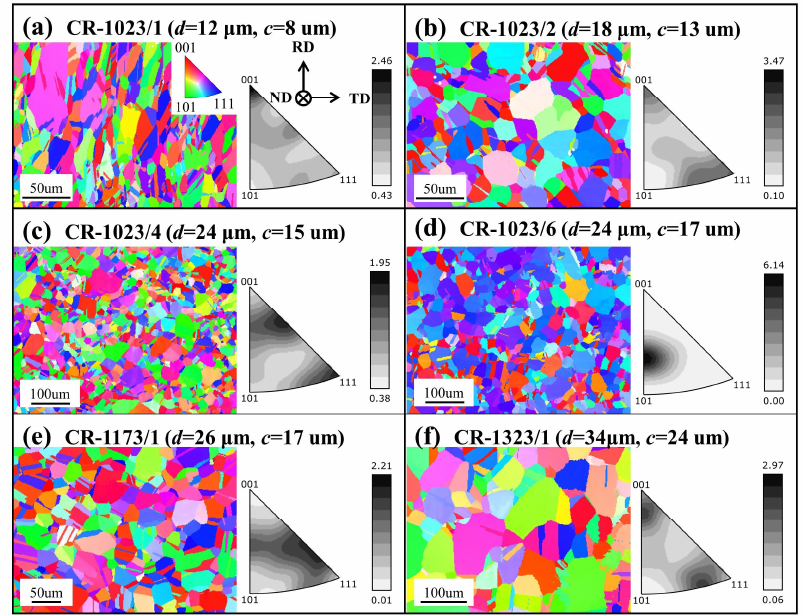
Figure 5. Representative microstructures and corresponding inverse pole figures showing the tex- ture parallel to the rod axis of recrystallized Ni 2 CrFe alloys with different grain and crystallite sizes: ( a ) d = 12 μm, c = 8 μm, ( b ) d = 18 μm, c = 13 μm, ( c ) d = 24 μm, c = 15 μm, ( d ) d = 24 μm, c = 17 μm, ( a ) d = 12 µ m, c = 8 µ m, ( b ) d = 18 µ m, c = 13 µ ( d ) d = 26 μm, c = 17 μm and ( d ) d = 34 μm, c = 24 μm.